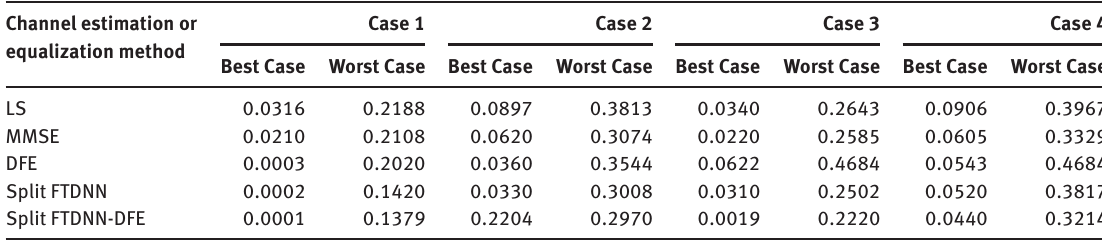
Table 2: Performance of the Proposed Systems Obtained in Terms of Average Value of the Mean Square after 15 Numbers of Random Trial.